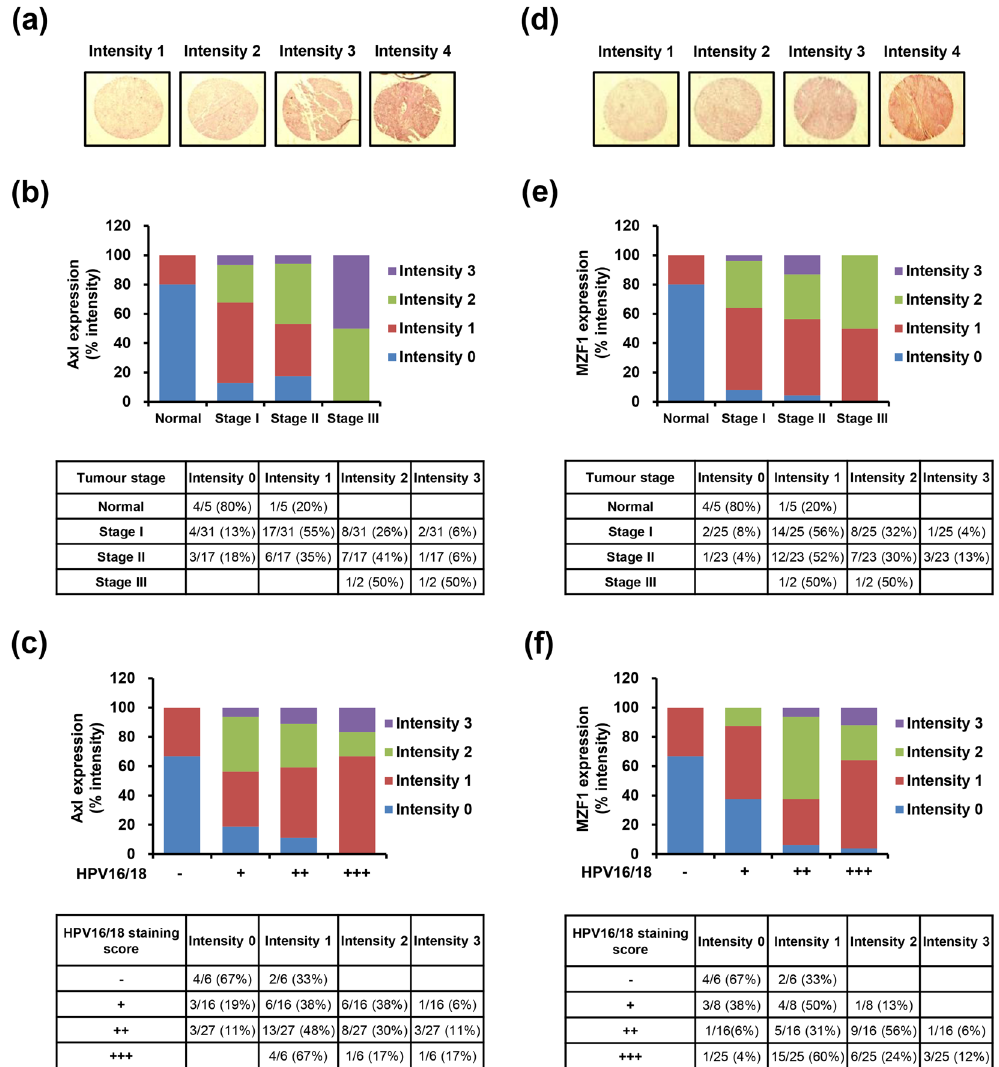
Figure 6. Correlation of the expression of Axl and MZF1 with clinical stage of cervical cancer and degree of HPV16/18 infection. ( a ) Representative images of normal and cervical cancer tissues with different IHC intensities positive for Axl. ( b ) The relative percentage of IHC intensity in normal and tumour stage-specific tissues was calculated from data of table, and Axl expression was represented as a bar graph. ( c ) Axl expression dependent on degree of HPV16/18 infection. ( d ) Representative images of IHC intensities positive for MZF1. ( e ) The intensities of MZF1 expression. ( f ) MZF1 expression dependent on degree of HPV16/18 infection. Normal: No evidence of primary tumor, Stage I: Tumor invades submucosa, Stage II: Tumor invades muscularis propria, Stage III: Tumor invades through muscularis propria into subserosa or into non-peritonealized pericolic or perirectal tissues. Staining scores for HPV16/18: “ − ” no staining; “ + ” weak staining; “ ++ ” moderate staining; “ +++ ” strong